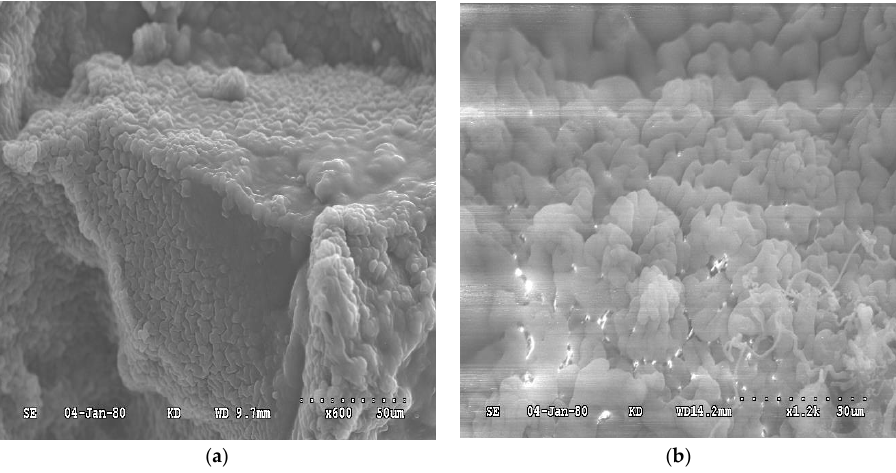
Figure 9. SEM image of the fold structure: ( a ) before soaking and ( b ) soaking for 15 days. From the SEM images, a large number of pores, cracks, and flake structures can be seen inside the coal samples. Before soaking, there is no obvious change on those structures as shown in Figures